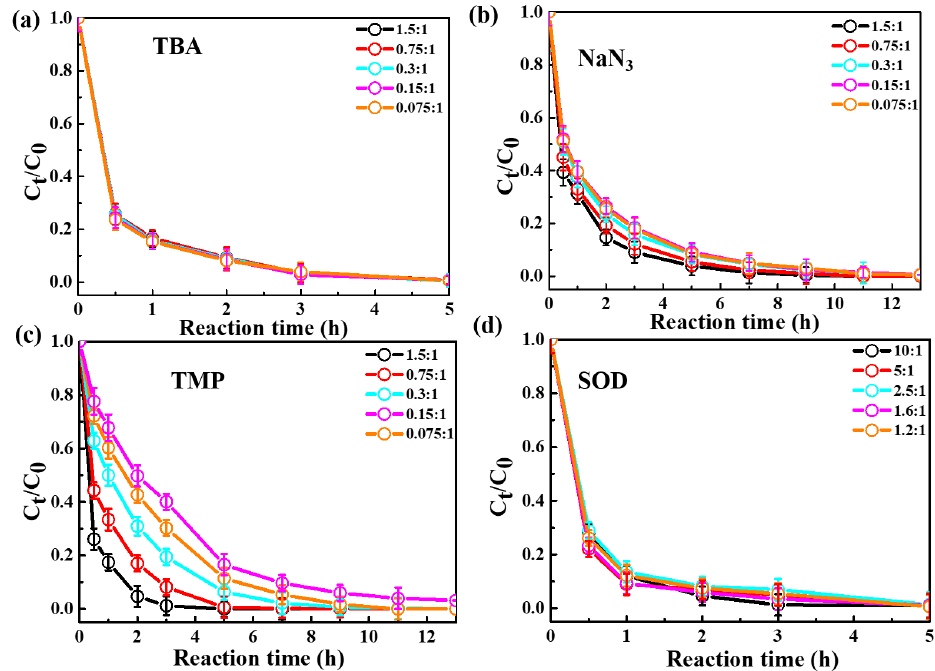
Figure 2. Ratio of unreacted eugenol concentration to its initial concentration ( C t /C 0 ) at different molar ratios of eugenol to the quencher, as a function of reaction time. (a) TBA. (b) NaN 3 . (c) TMP. (d) SOD.